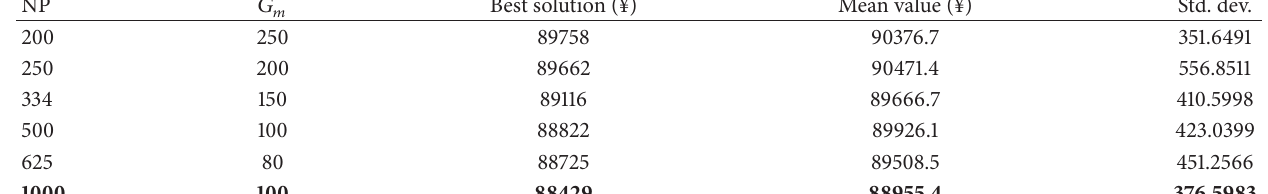
Table 4: Analysis of NP and 𝐺 𝑚 of TSDE.